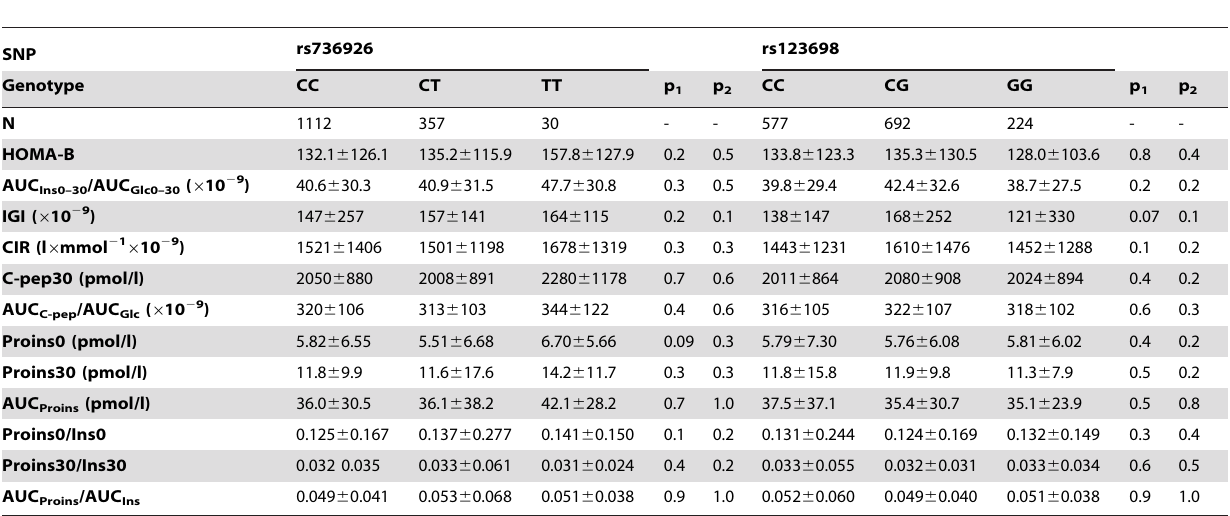
Table 4. Associations of PTBP1 SNPs rs736926 and rs123698 with insulin secretion and proinsulin conversion in non-diabetic subjects (N =1502).